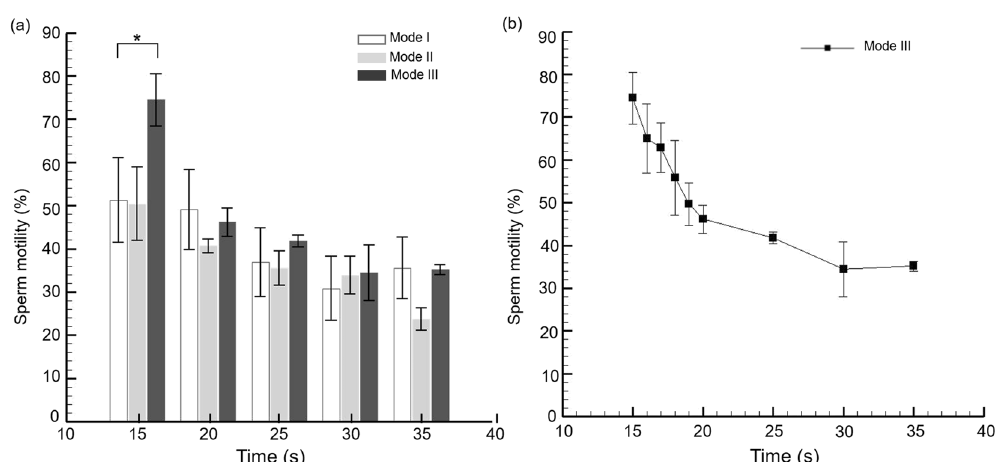
Figure 3. ( a ) Zebrafish sperm activation corresponding to the increase in time for the three different experimental modes. A one way ANOVA test was performed and a p -value < 0.05 considered to be statistically significant ( * ). ( b ) Time dependency of the sperm activation rate in Mode III illustrates a progressive decline in a time window of 15–20 s illustrating the importance of artificial cilia to the sperm